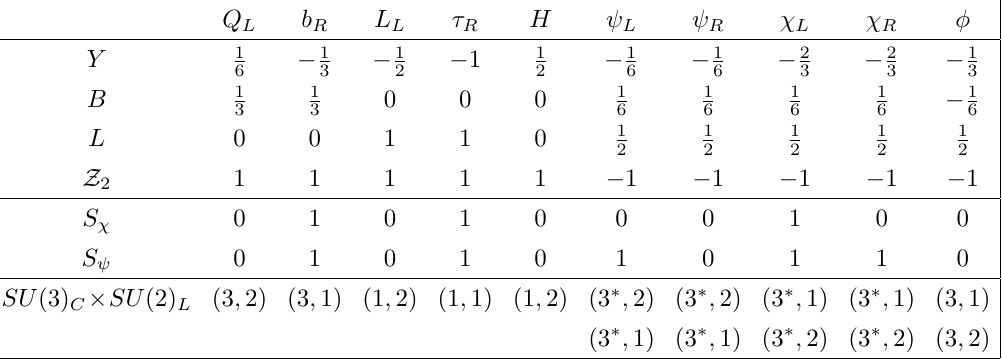
Table 8. Quantum numbers of the fields for the minimal Class 2 combined models. The last two lines list the models containing only singlets and fundamentals under the SM gauge